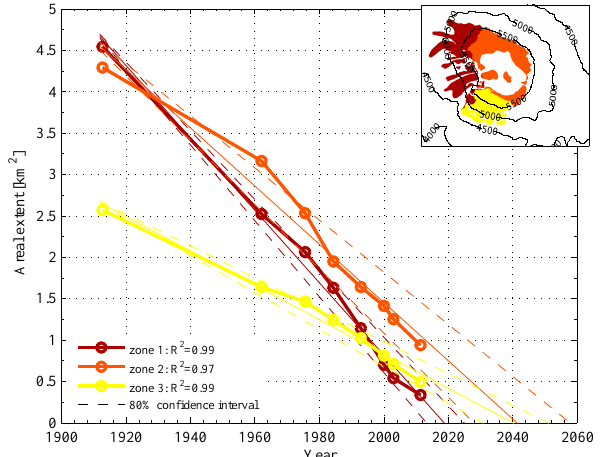
Fig. 5. The areal change of glaciers and ice bodies based on the three-member classification. Linear regressions (thin solid lines) for each of the three zones are shown, as well as the 80% confidence intervals for each of these